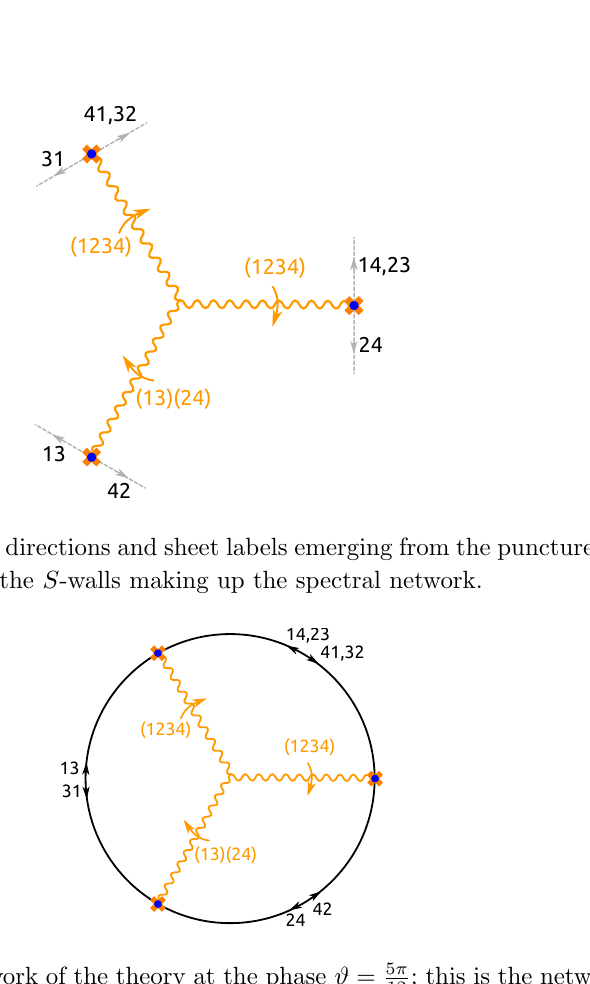
; this is the network relevant for 12 = 1 there is a wall labeled 1